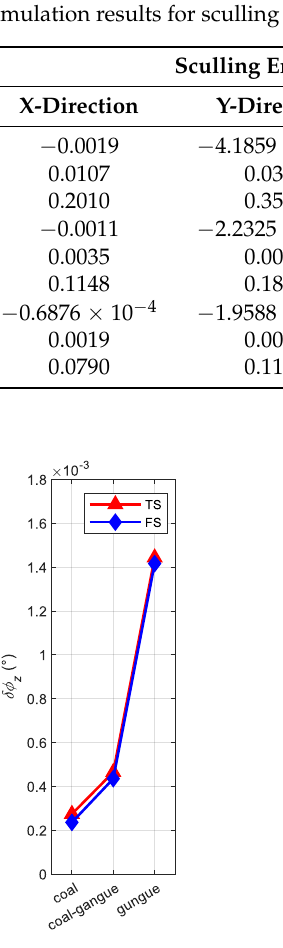
Figure 10. The coning error statistics using three-subsample (TS) compensation algorithm and four-subsample (FS) compensation algorithm under different coal and rock characteristics.